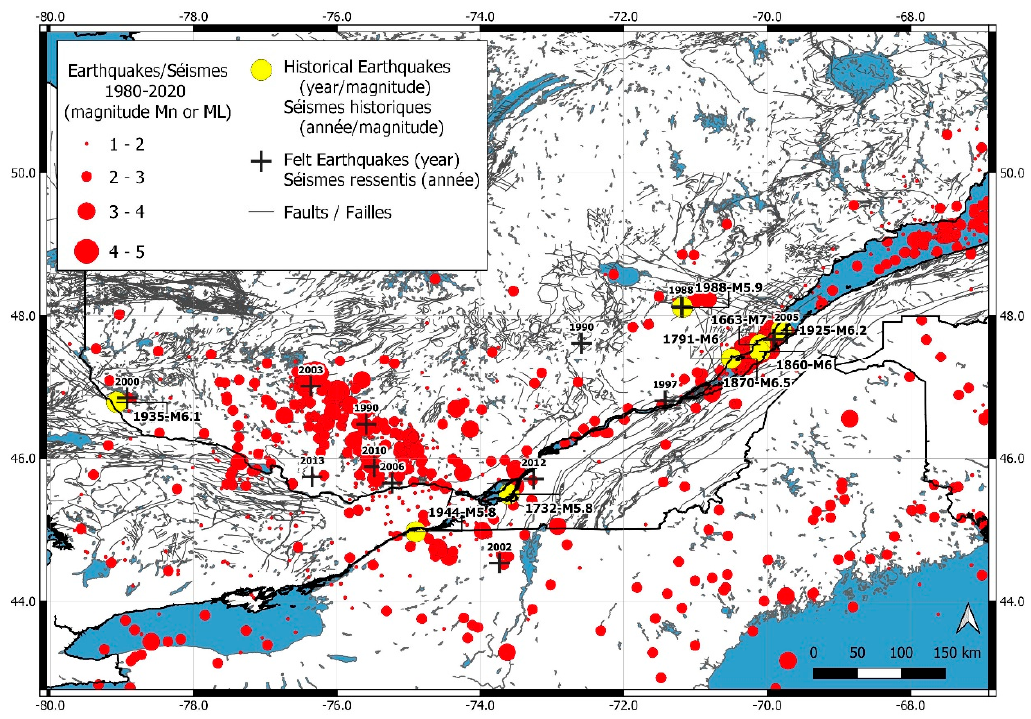
Figure 1. Felt historical and recorded earthquakes around the Greater Montreal area for the period 1663–2020. The earthquakes list is provided by Natural Resources Canada and fault lines from the Ministère de l’Énergie et des Ressources naturelles of the Quebec province and the Ontario Geological Survey.